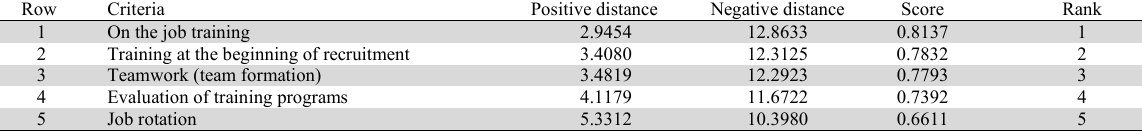
The results of training and development sub-criteria ranking Row Criteria Positive distance On the job